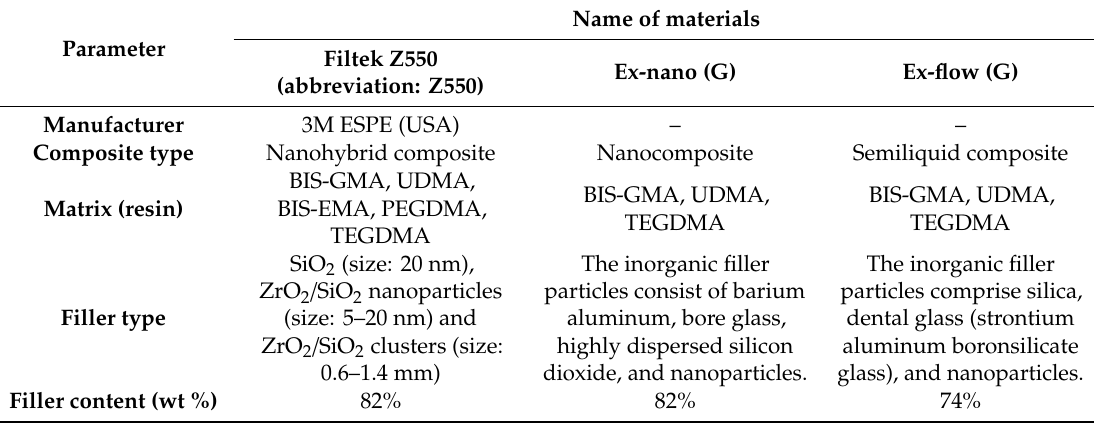
Table 1. Details about the tested